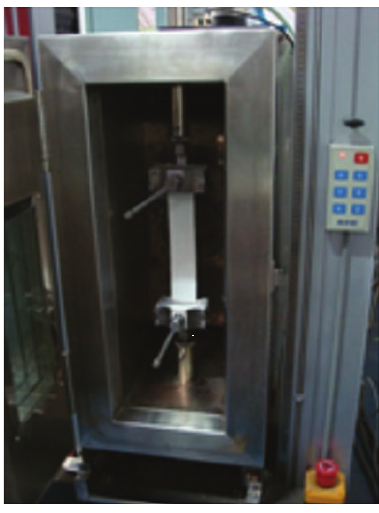
Figure 4: Uniaxial tensile machine with temperature